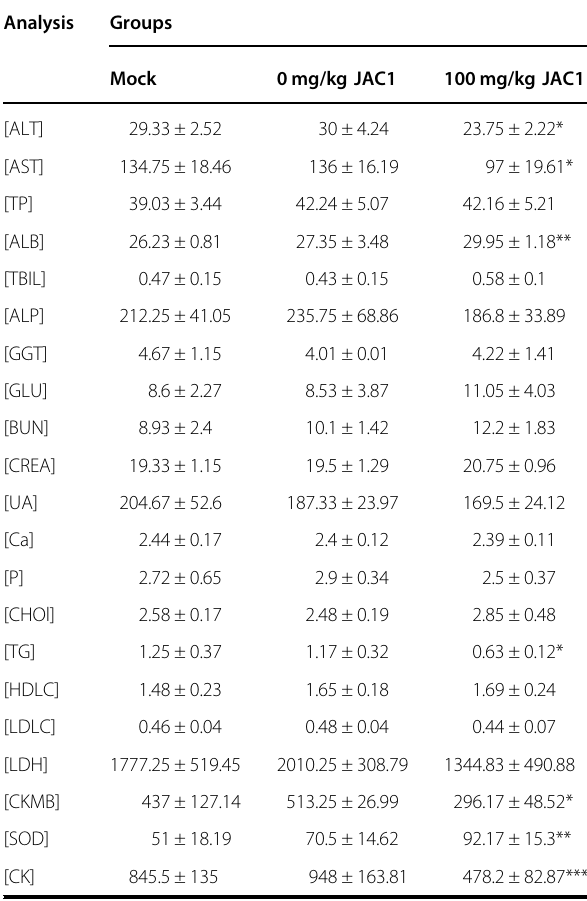
Table 1 The serum biochemical indexes (21 parameters) in control and 100 mg/kg JAC1-treated mice.